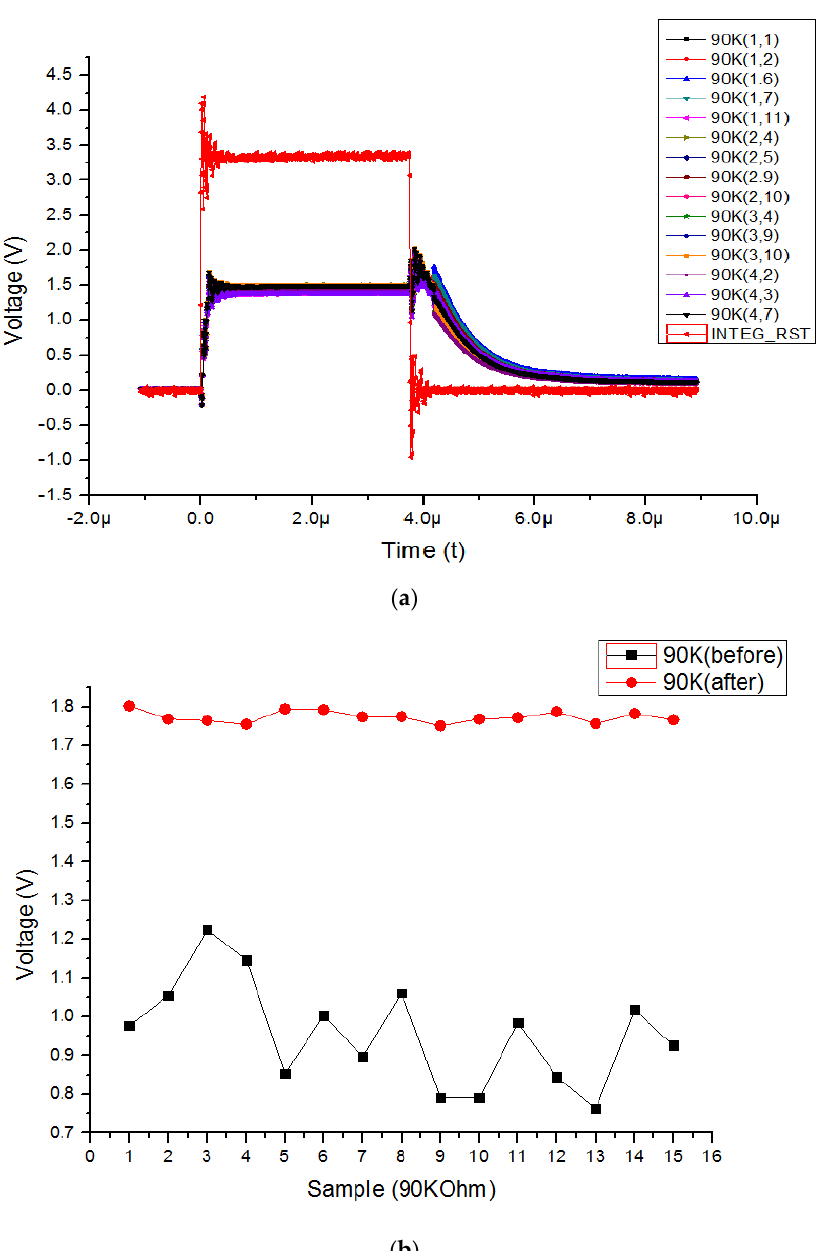
Figure 6. ( a ) The 90 k Ω active pixel output voltage according to integrator reset voltage before calibration ( b ) experimental results before and after applying proposed adjustment technique to the 90 k Ω active pixel.